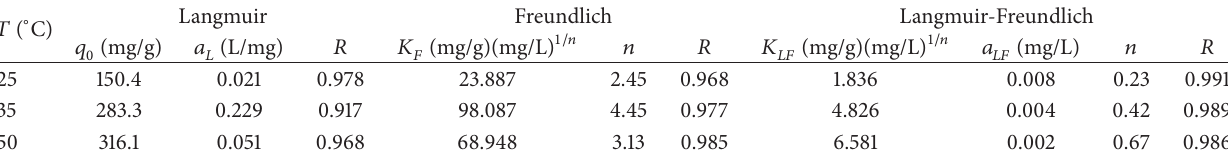
Table 4: Isotherm model parameters and correlation coefficients ( R ) for lead biosorption by